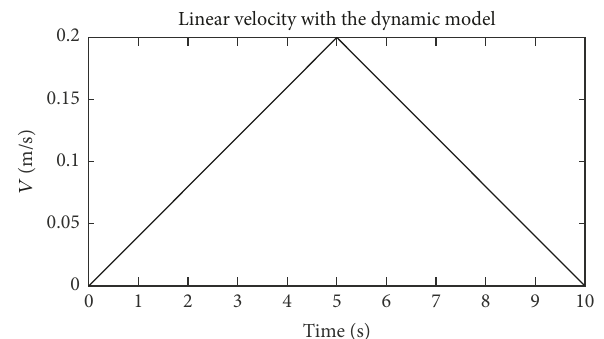
Linear velocity with the dynamic model